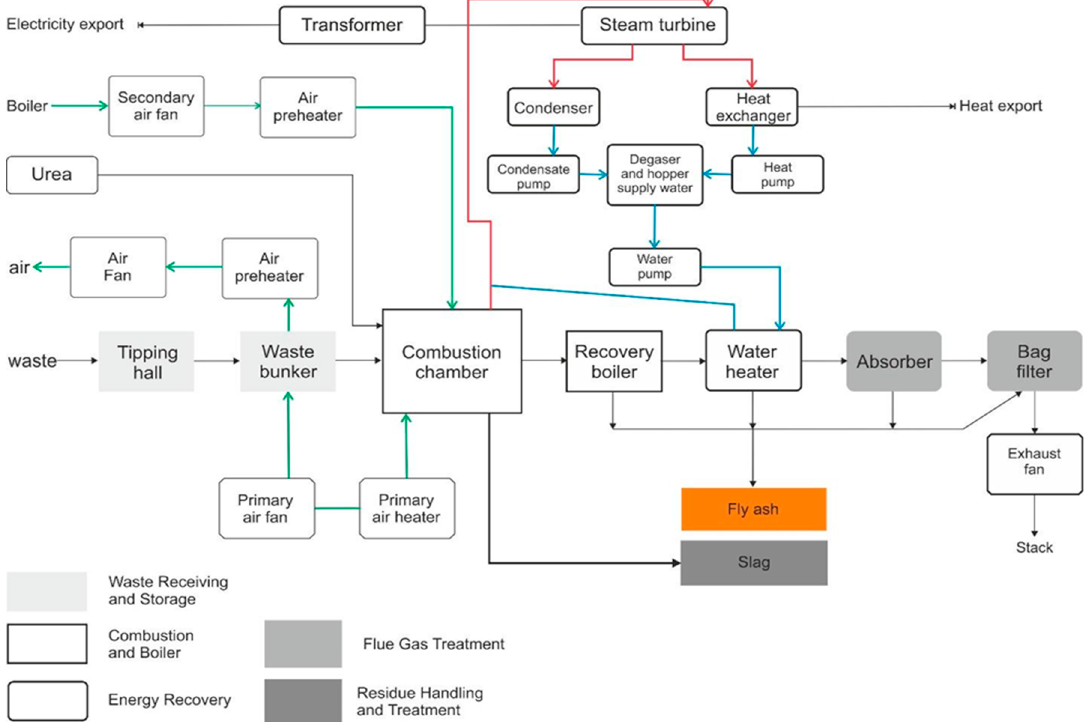
Figure 1. Simplified scheme of the analyzed municipal solid waste (MSW) incinerator.